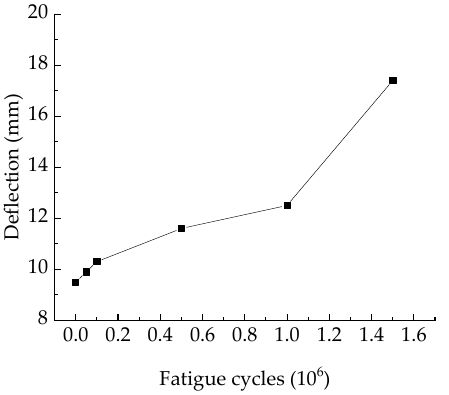
Figure 17. The relationship between the mid-span deflection and fatigue cycles of P2.